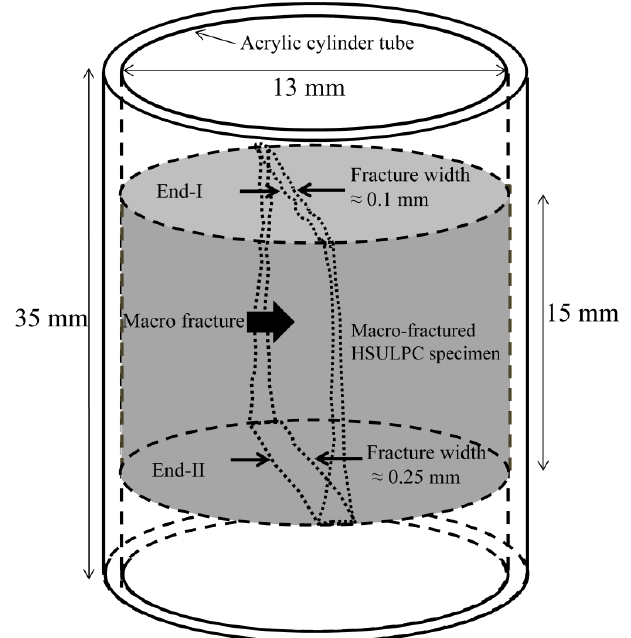
Figure 1. Schematic of macro-fractured HSULPC